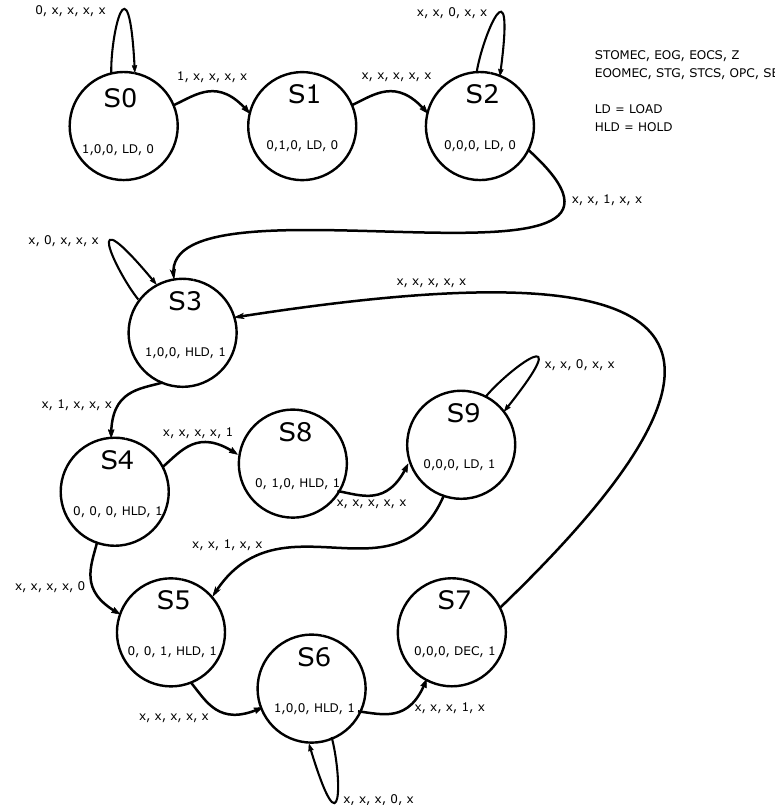
Figure 9. FSM_CONT_MEC module in the FPGA-based optimization algorithm. The digital architecture of the optimization algorithm uses a fixed point format (16,24) to represent all the input-output signals and inner operations. The hardware description used to develop the digital architecture was VHDL and the target board used was the Cyclone II EP2C35F672C6 integrated in the ALTERA DE2 educational board with a clock frequency f CLK = 50